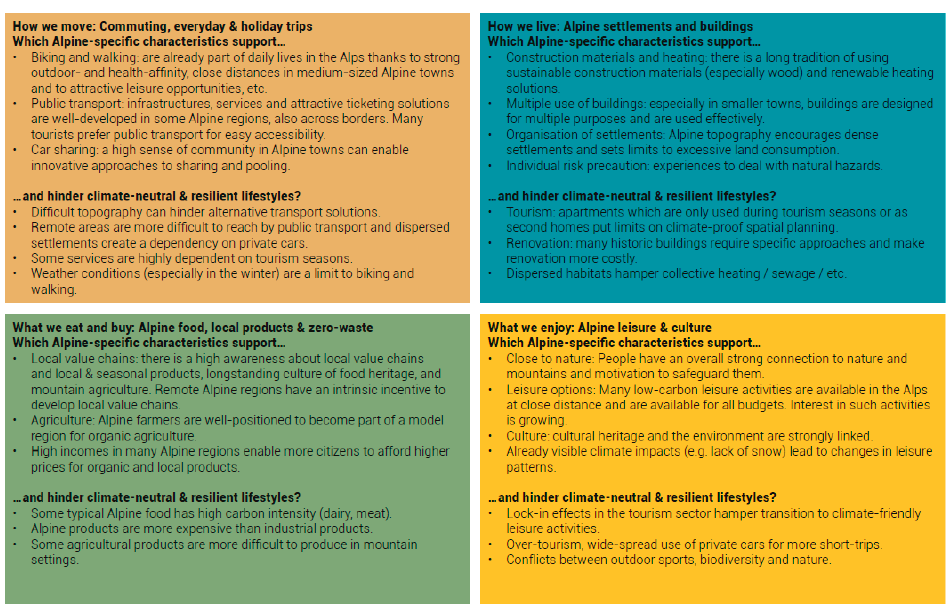
Figure 4. Alpine-specific opportunities ant threats to develop climate-neutral & resilient lifestyles. Figure 4. Alpine ‐ specific opportunities ant threats to develop climate ‐ neutral & resilient lifestyles. Source: Closing the gap on climate action, Alpine Convention, 2022 Source: Closing the gap on climate action, Alpine Convention, 2022 [57].